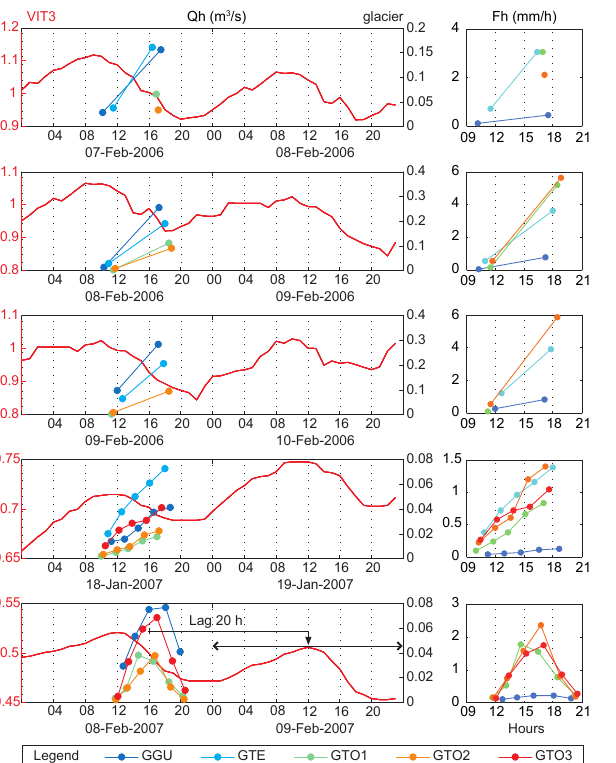
Fig. 6. Left: hourly discharge (m 3 s − 1 ) at VIT3 automatic station (continuous red line) and instantaneous measurements of glacier runoff (see Table 4). Right: glacier discharges were converted to specific rates of melting (mmw.e.h − 1 ). Hours are given in local time.